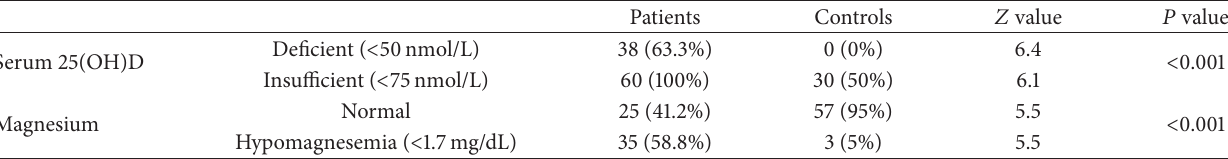
Table 3: Serum 25(OH)D and magnesium levels in patients and controls.